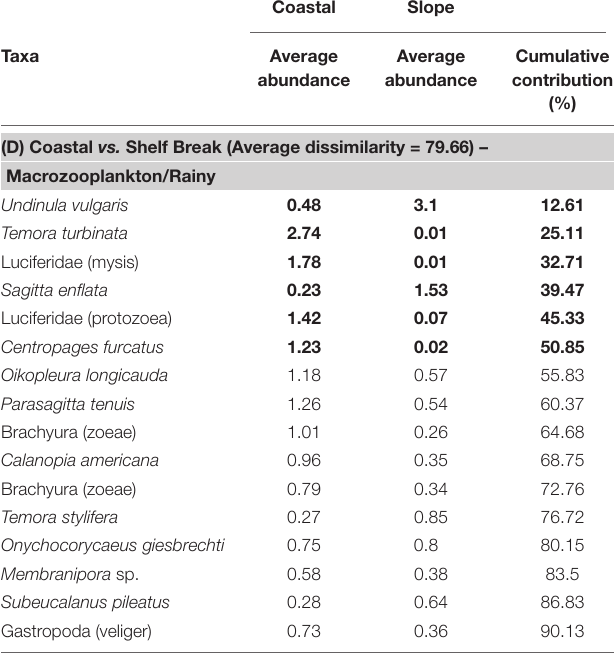
TABLE 5 | Results of SIMPER analysis for micro-, meso- and macrozooplankton and the zooplankton taxa that contributed to the composition and their values in %, off Rio Grande do Norte, Southwestern